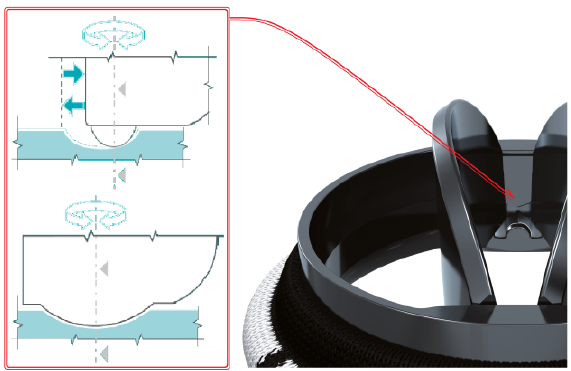
Fig. 1. The hinge mechanism of the Sorin Bicarbon valve [15]